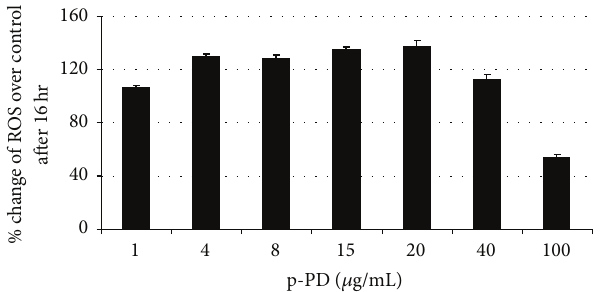
Figure 8: p-PD treatment increases the level of ROS in A375 cells. Control cells and cells treated with p-PD for 16 hours were subjected to DCFH-DA stain. Flow cytometric analyses of the stained cells were done as described in the Materials and Methods. One experimental data set is shown here. The percentage change of − ROS ) ROS was calculated using the expression (ROS Experiment Control × 100/ROS . Each set was performed in Control